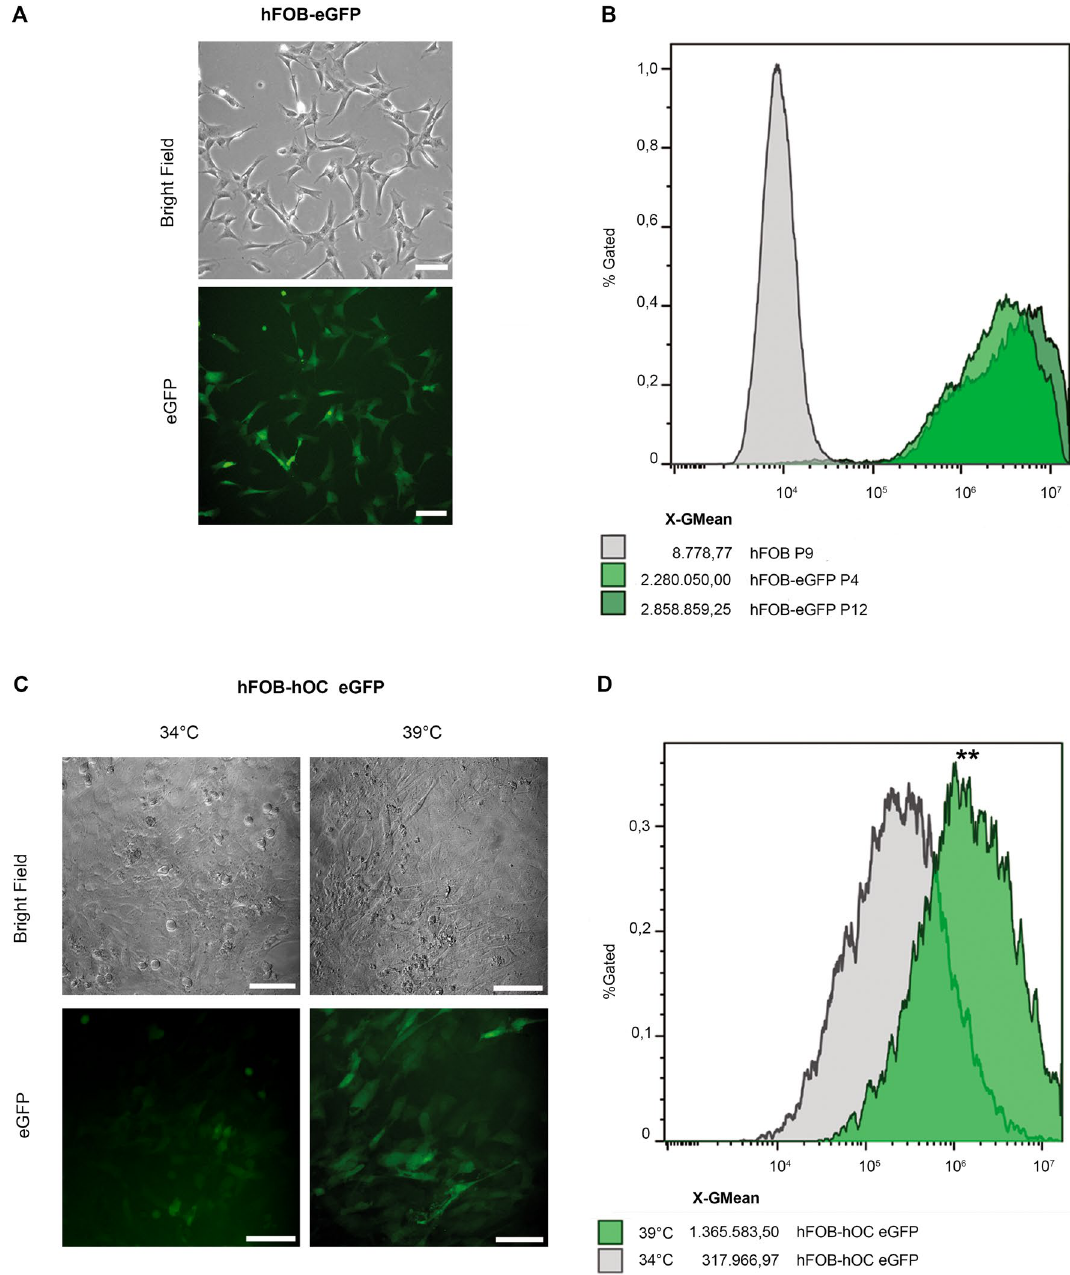
Figure 2. Transgenic hFOB reporter cell lines. ( A ) hFOB cells were transduced with a recombinant lentivirus vector bearing the reporter construct UbC-eGFP resulting in the cell line hFOB-eGFP. Constitutively active expression of eGFP was visualized by fluorescence microscopy. Bars indicate 100 µm. ( B ) Stable eGFP expression over cell passaging was assessed by flow-cytometry comparing wild-type hFOB (in grey) with hFOB- eGFP (in green) at low (P4) and high cell passage (P12). Data acquisition and analysis were performed by means of Cytoflex S, software CytExpert and Kaluza. ( C ) An inducible cell line expressing eGFP under the control of the full length promoter for the human osteocalcin (hFOB-hOC eGFP) was transduced and differentiation was induced by incubation at 39 °C for 3 days. Images of cells incubated at 34 °C (undifferentiated control) versus induced cultures at 39 °C were taken to monitor eGFP expression. ( D ) Representative histograms of flow-cytometric analysis of reporter gene expression in hFOB-hOC eGFP activated at 39 °C (green) for 3 days. Uninduced cells cultured at 34 °C (in grey) displayed a basal expression of eGFP. Geometric mean of fluorescence intensity is indicated. Statistical significance of reporter activity at 39 °C of three independent experiments was calculated using an unpaired Student t